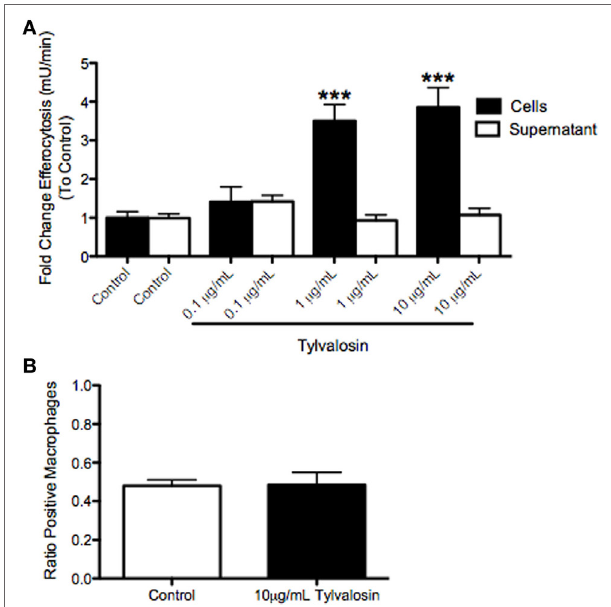
FigUre 4 | Tylvalosin promotes efferocytosis, but does not modulate mannose-dependent phagocytosis in porcine monocyte-derived macrophages in vitro . (a) Myeloperoxidase (MPO), a marker for neutrophils, was found at increasing concentrations in macrophages given neutrophils treated with tylvalosin for 0.5 h. Porcine macrophages were treated for 2 h with untreated neutrophils (control; 10% FBS in HBSS for 0.5 h) and PMNs treated with 0.1, 1, or 10 μ g/mL tylvalosin for 0.5 h. Values are expressed as a fold change to control of MPO activity measured in mU/min. Data are mean ± SEM ( n = 3/group). *** P < 0.001 versus control. (B) Mannose-dependent phagocytic activity of zymosan particles is not changed in porcine macrophages that show increased efferocytosis at 2 h. Monocyte-derived macrophages were incubated with 1 mg/mL of zymosan particles in control media (10% FBS in HBSS) or 10 μ g/mL TVN in IMDM for (B) 2 h ( n = 6/ group). Macrophages containing one or more ZYM (zymosan) particles were counted as “positive cells,” and values were calculated as a ratio of positive macrophages versus total macrophages. Data are means ±